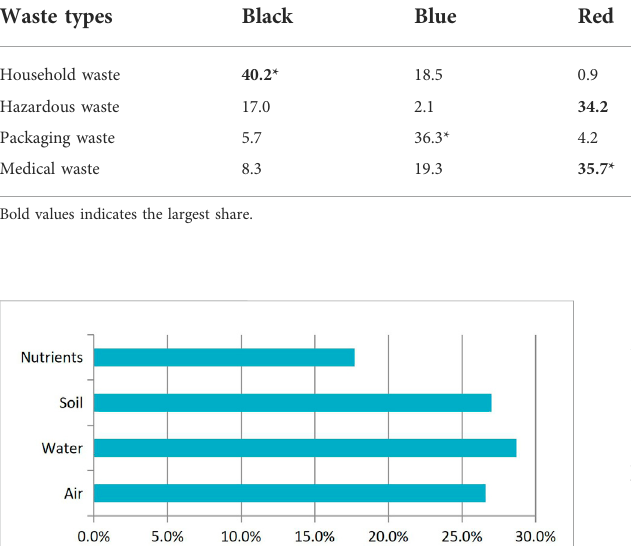
TABLE 4 Percentage table of responses about waste bags.